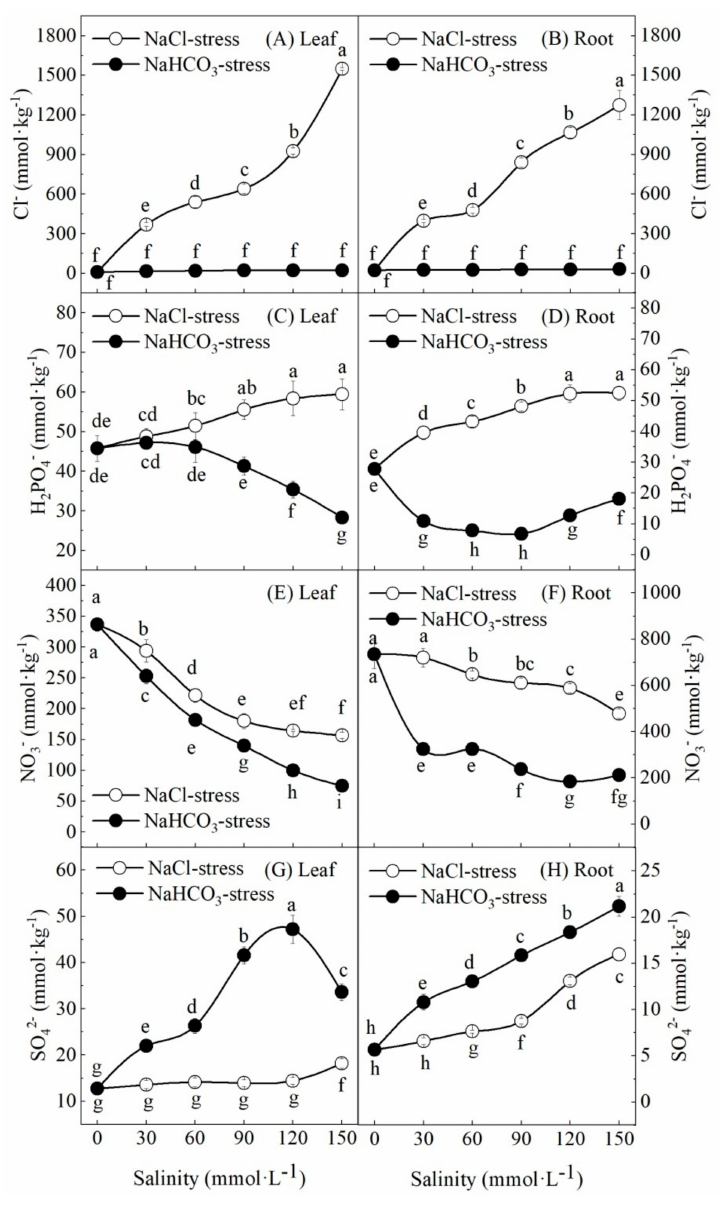
Figure 5. E ff ects of NaCl and NaHCO 3 stresses on Cl − ( A , B ), H 2 PO 4 − ( C , D ), NO 3 − ( E , F ), and SO 42 −